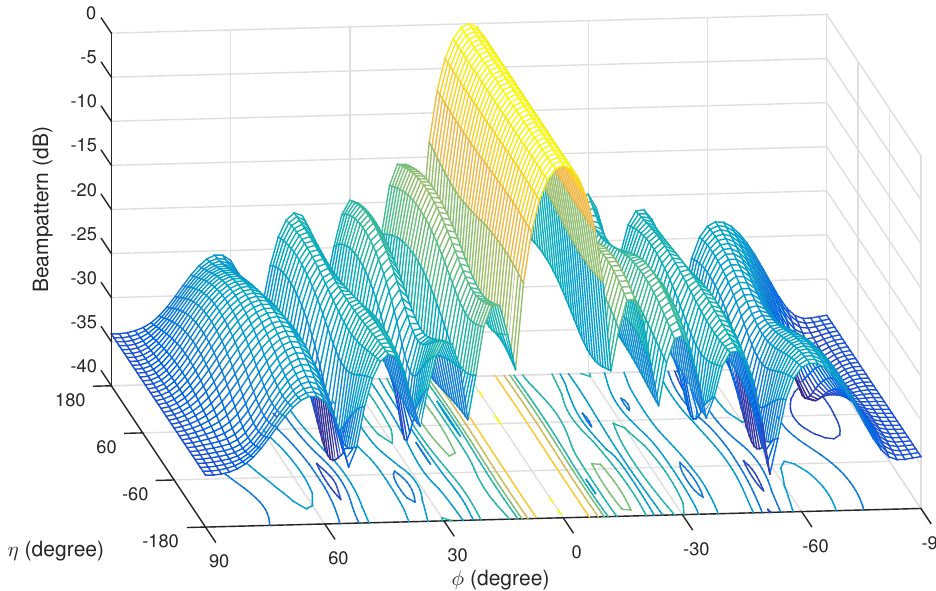
Figure 5. The resultant full quaternion worst-case constraint beamformer (FQWCCB) beam pattern with θ = 90 ◦ and γ = 60 ◦